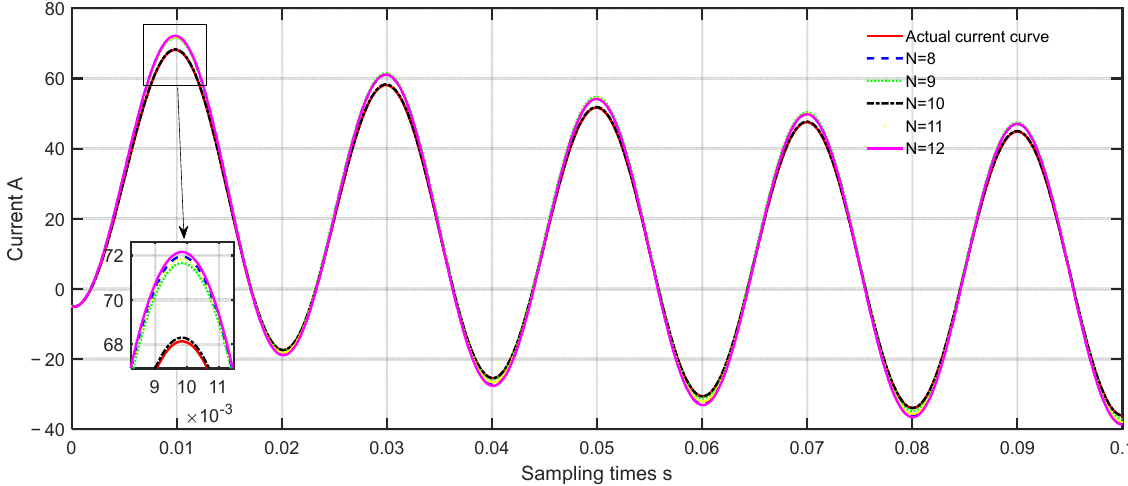
Figure 4. Waveform for different values of n . Table 1. Error in waveform parameters when n is taken as different values.